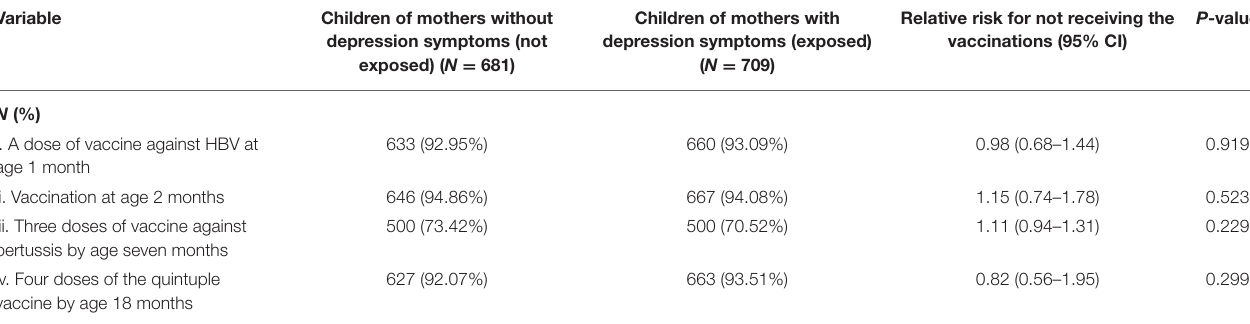
TABLE 3 | Relative risk values for non-vaccination of children whose mothers had PPD symptoms in comparison to children whose mothers had no PPD symptoms.